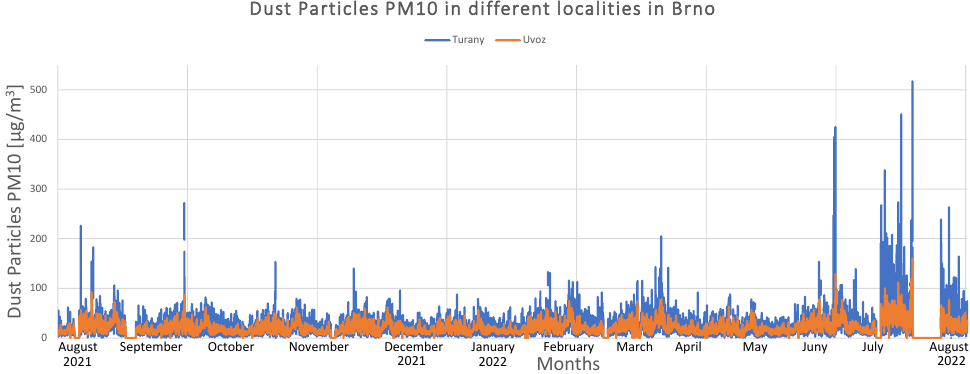
Figure 8. P10 pollutant monitored in